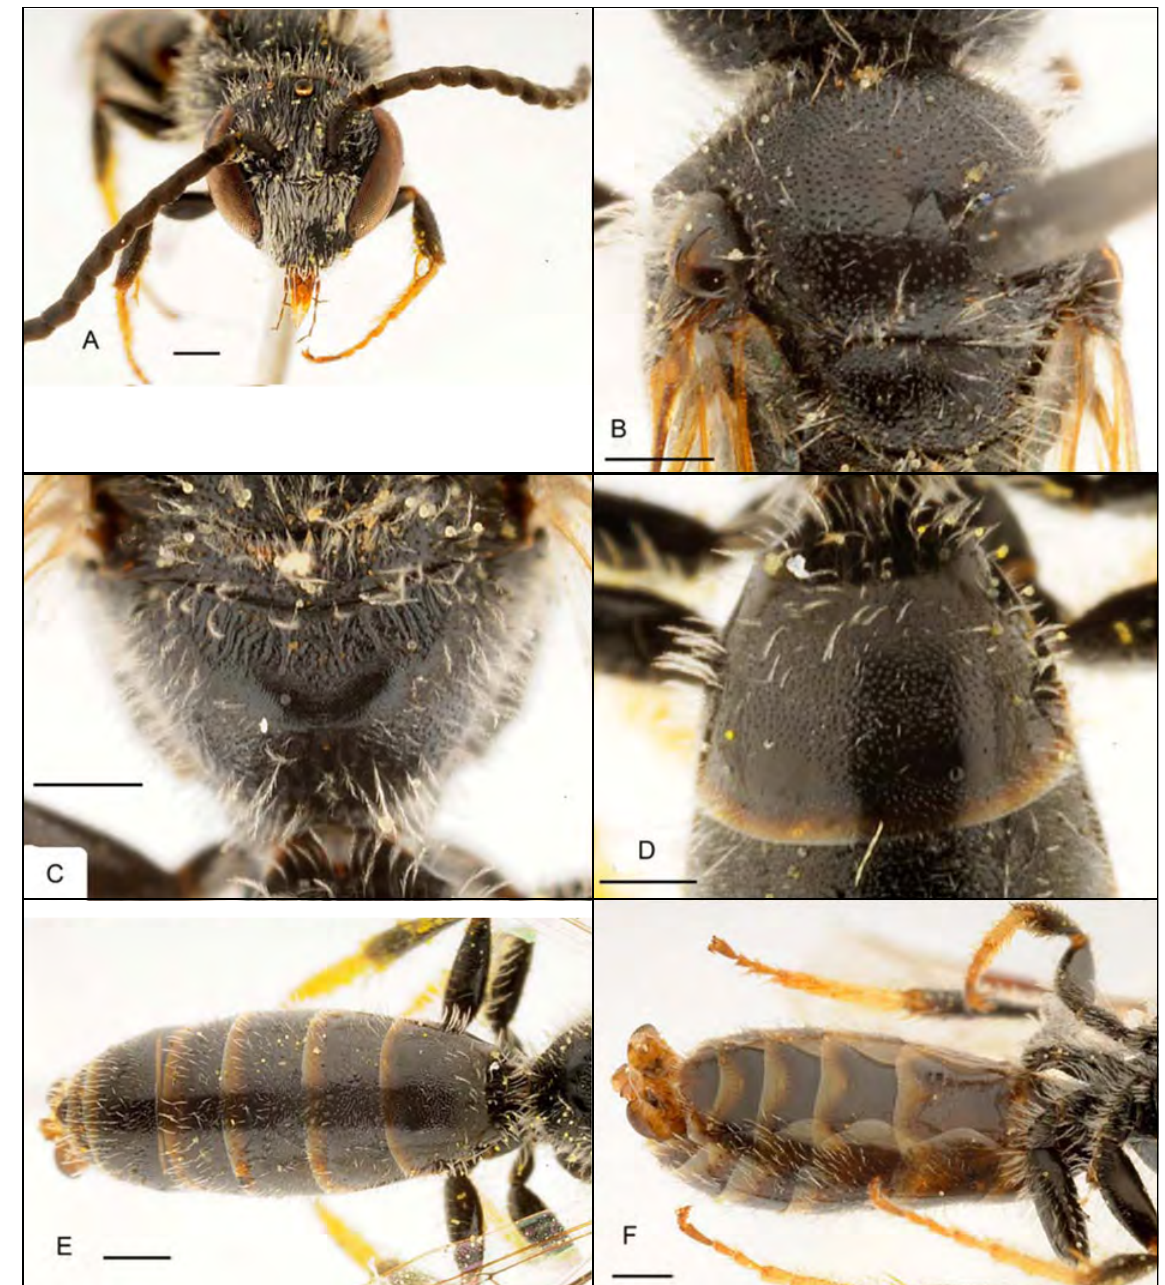
Fig. 4. Lasioglossum ( Capalictus ) hantamense sp. nov., ♂. A . Head. B . Mesoscutum and scutellum. C . Propodeum and metanotum. D . First tergum. E . Metasoma, dorsal view. F . Metasoma, ventral view. Scale line = 0,5